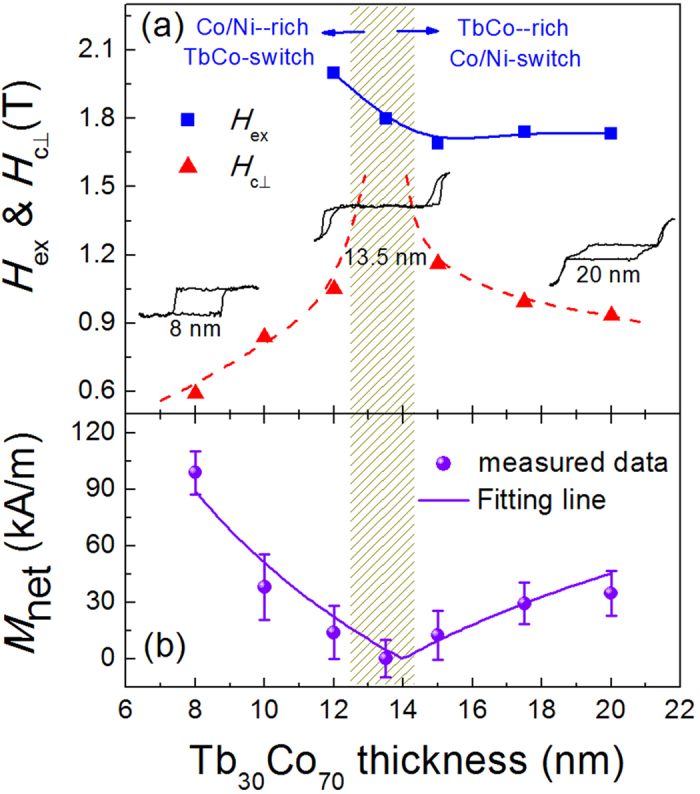
The influence of Tb30Co70 thickness on the magnetic properties.(a) The perpendicular coercive field Hc⊥ and exchange coupling field Hex, and (b) remanent net magnetization Mnet as a function of Tb30Co70 thickness for samples of [Co0.28/Ni0.58]5/ Tb30Co70 (t). Insets: Magnetic hysteresis loops for t = 8, 13.5, and 20 nm.